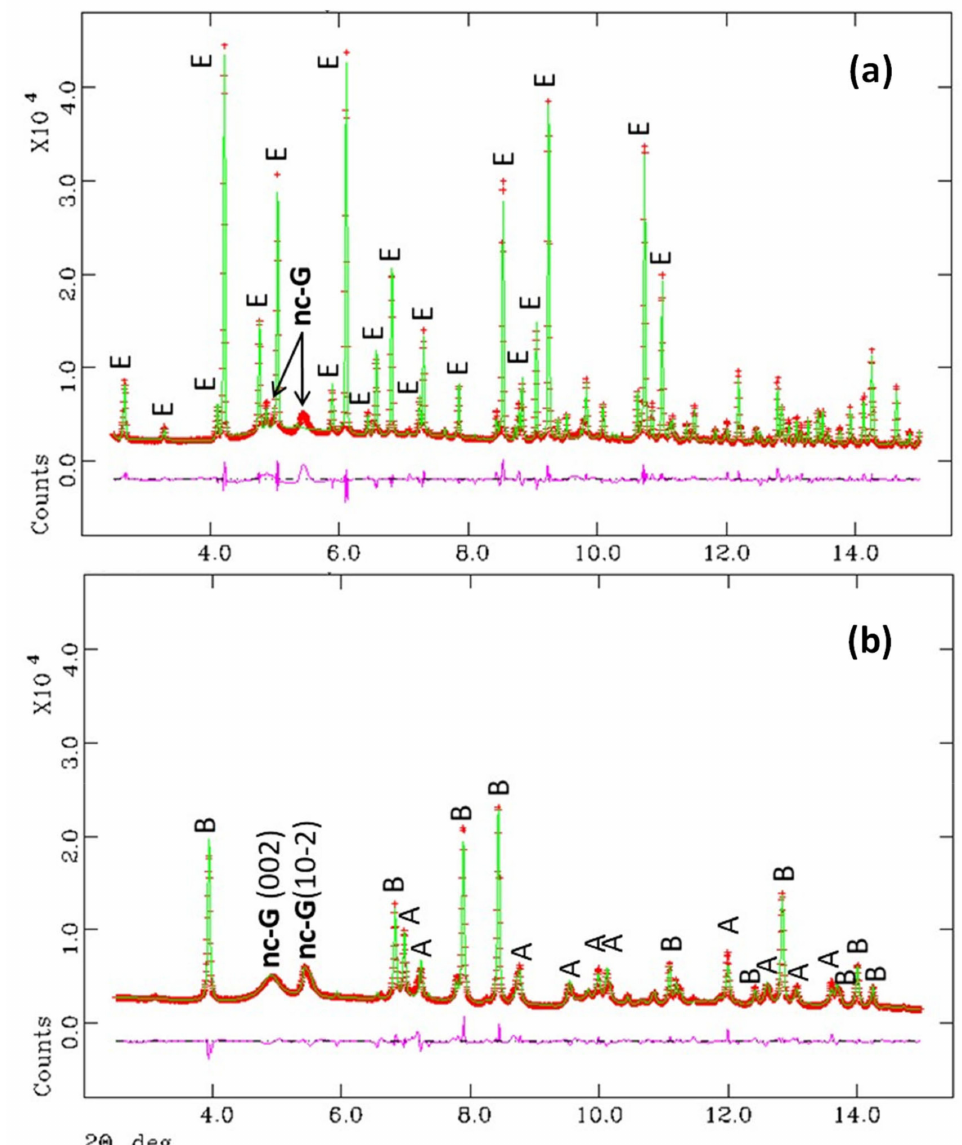
Figure 3. Selected low angle ranges (intensity vs 2 θ ) of the synchrotron Rietveld plots ( λ = 0.41 Å) for ( a ) Y-A_hyd, hydrated for 1.5 months and ( b ) Y-A_carb paste after carbonation for 80 days at 3% of CO 2 (T = 20 ◦ C and RH = 65%). The top pattern contains crystalline ettringite and very broad diffraction peaks of nano-gibbsite. The main peaks are labelled. Top pattern: ettringite (E) and nanocrystalline-gibbsite ( nc-G ). Bottom pattern: aragonite (A), bassanite (B), nanocrystalline-gibbsite ( nc-G ) [including their (hkl)